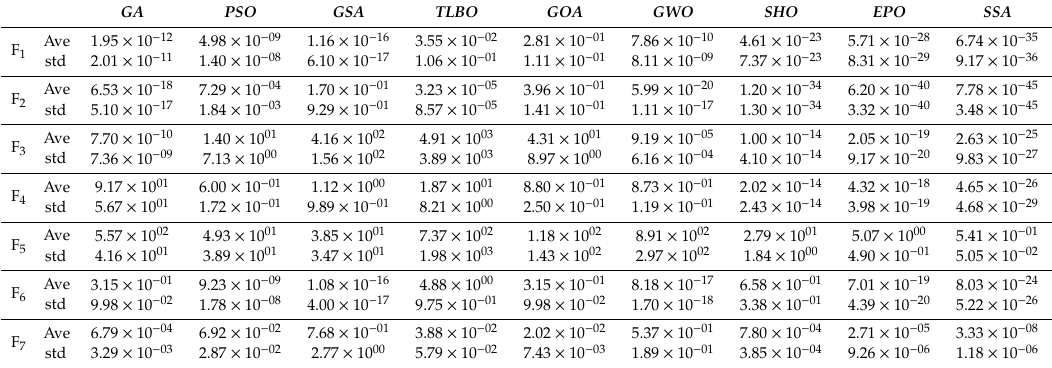
Table 1. Results for SSA and other algorithms in Unimodal test